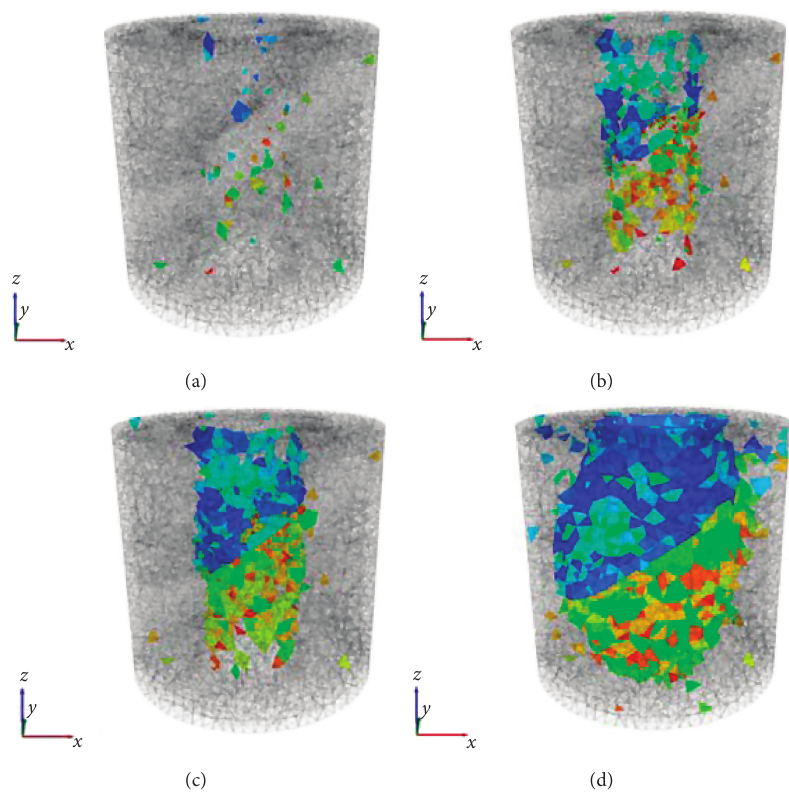
Figure 11: Perspective view of the rock fragments at four different states for the TWC test on a rock sample containing an initial crack (the colored blocks represent failed rock fragments, while the grey line segments in the plots illustrate the outlines of the unfailed